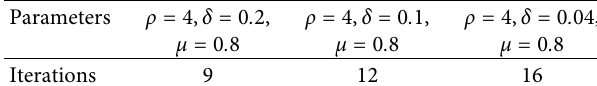
Algorithm 1 are mentioned in Table 1. Tables 2 and 3 represent the outcomes of Algorithm 2 with the initial point α 0 � − A − 1 q for the order n � 100 of the generated matrix . For all output, we consider μ , δ ∈ ( 0 , 1 ) , c ∈ [ 1 , 2 ] , and ρ > 0 . The iterative process will stop when we have r ( α , ρ ) ≤ 10 − 7 . n n